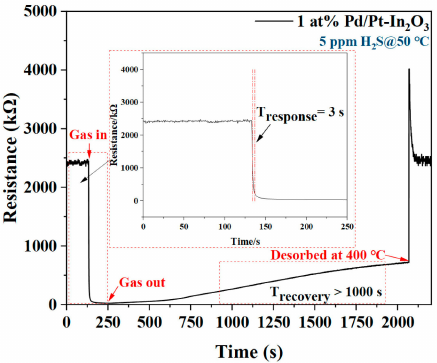
Figure 6. Response/recovery time of 1 at% Pd/Pt-In 2 O 3 for 5 ppm H 2 S at 50 ◦ C.